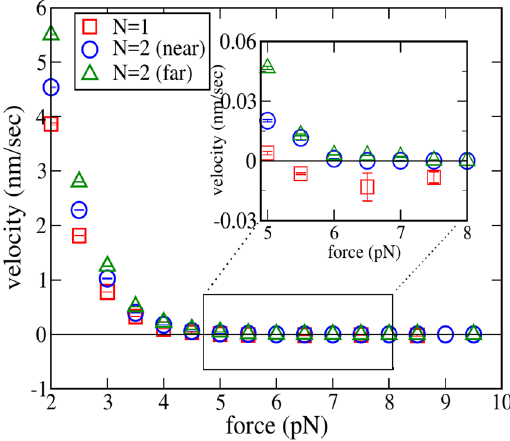
Figure 7. Force-velocity relation for a single microtubule and two microtubules, both near (zero base separation) and far (base separation of 150 nm). The values of the parameters used in the simulation are listed in Table 1. The inset zooms the force range where the velocity vanishes. Note that while the single filament curve crosses the x -axis after touching zero at stall, the two-filament velocity remains close to zero after stall. In most cases, the error bars are smaller than the size of the symbols. For two filaments, ‘near’ means zero base separation, while ‘far’ refers to a base separation 150